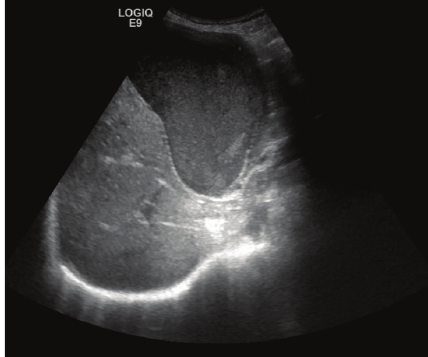
Figure 2: Ultrasound abdomen demonstrating a grossly distended gallbladder with a thickened posterior wall.